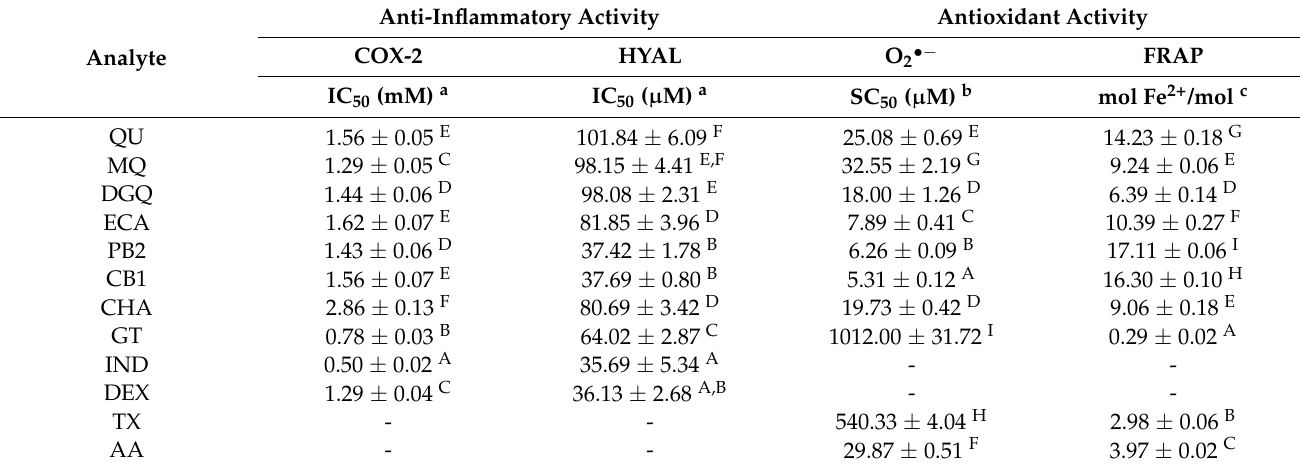
Table 2. Anti-inflammatory and antioxidant activity of the selected